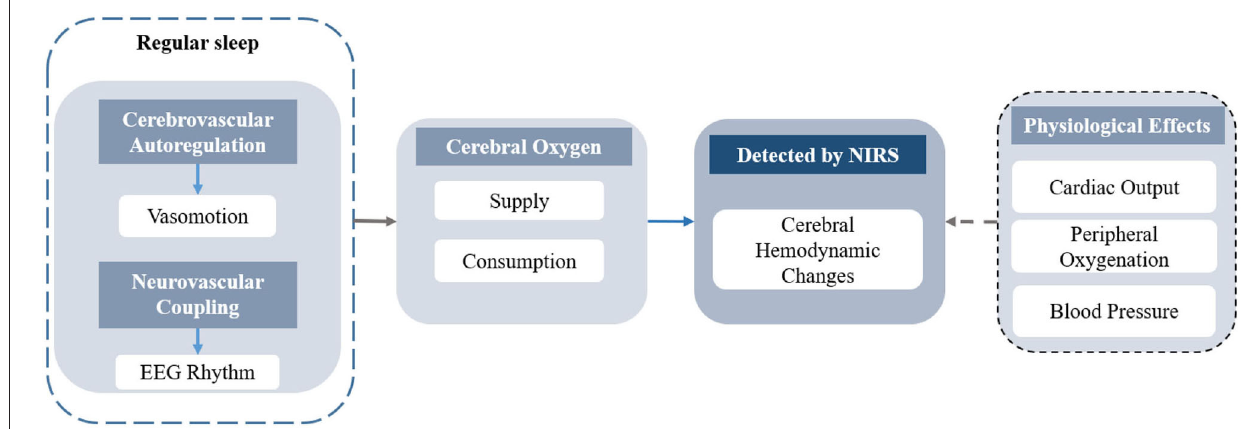
FIGURE 5 | The diagram of the cerebral hemodynamics regulation in regular sleep.